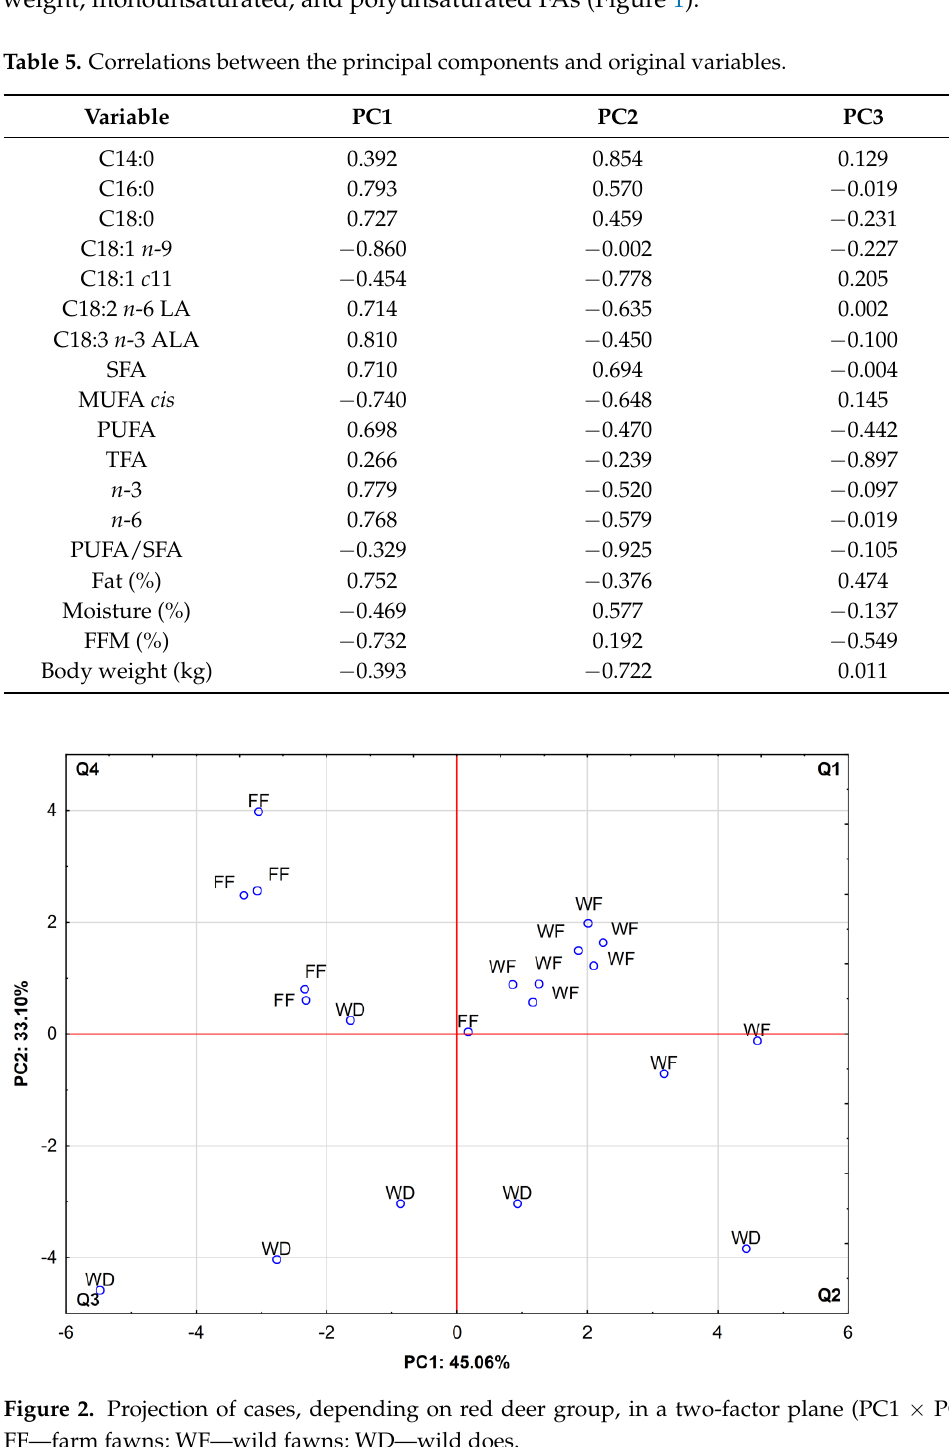
Table 6. Correlations between the body weight and bone marrow characteristics. Variable